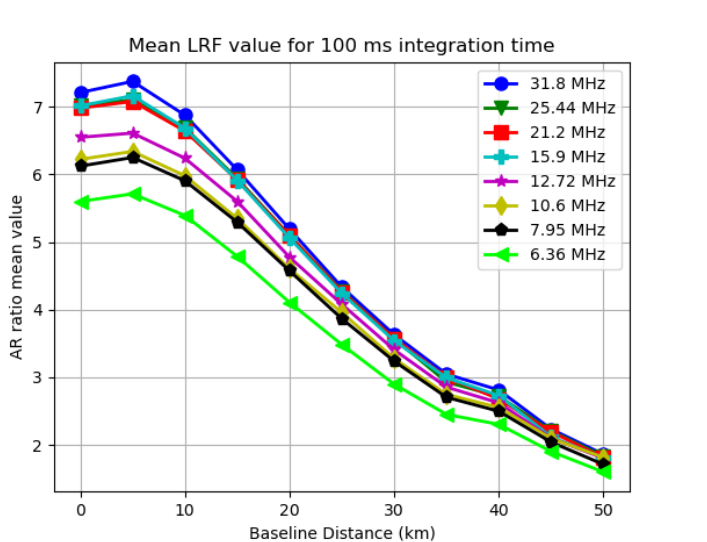
Figure 9. Mean LRF value for different bandwidths when 100 ms integration time is